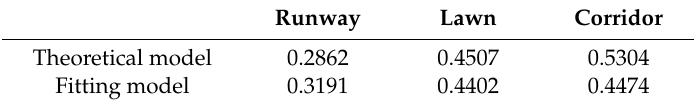
Table 3. The root mean square errors (RMSEs) of the mapping models in di ff erent environments.